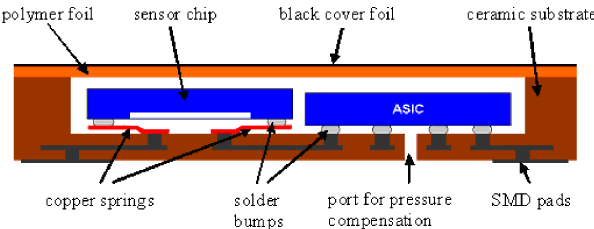
Figure 12. Novel flip-chip packaging technology for pressure and humidity sensor chips. High-temperature cofired ceramic (HTCC) is used for the package. The sensor chip is flip chip bonded on cop- per springs to obtain a stress-free package.